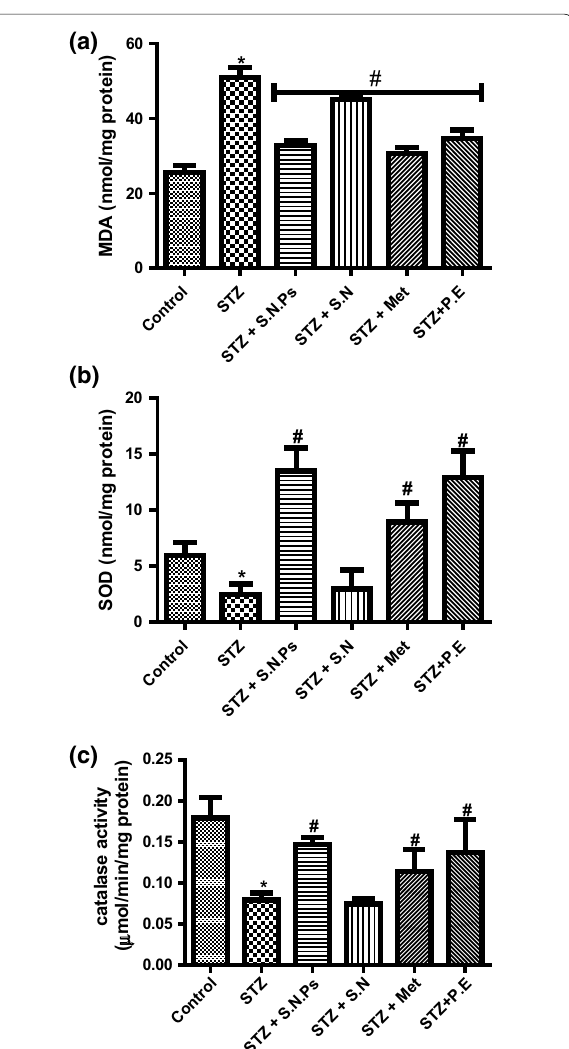
Fig. 5 a Effects of M. charantia nanoparticles on ALT. ALT activity was determined by using the serum of diabetic rats as described in “Methods” section. Values are mean SEM of five experimental ± animals ( n 5). * represents significant difference ( p < 0.05) to = control, while # represents significant difference ( p < 0.05) to STZ (diabetic control) group. b Effects of M. charantia nanoparticles on AST. AST activity was determined by using the serum of diabetic rats as described in “Methods” section. Values are mean SEM of ± five experimental animals ( n 5). * represents significant difference = ( p < 0.05) to control, while # represents significant difference ( p < 0.05) to STZ (diabetic control) group. c Effects of M. charantia nanoparticles on ALP. ALP activity was determined by using the serum of diabetic rats as described in “Methods” section. Values are mean SEM of ± five experimental animals ( n 5). * represents significant difference = ( p < 0.05) to control, while # represents significant difference ( p < 0.05) to STZ (diabetic control) group